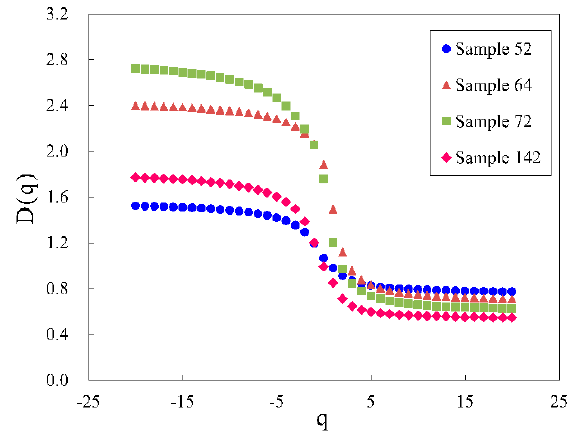
Figure 6. Plot of the multifractal generalized dimension D ( q ) versus the moment order q .